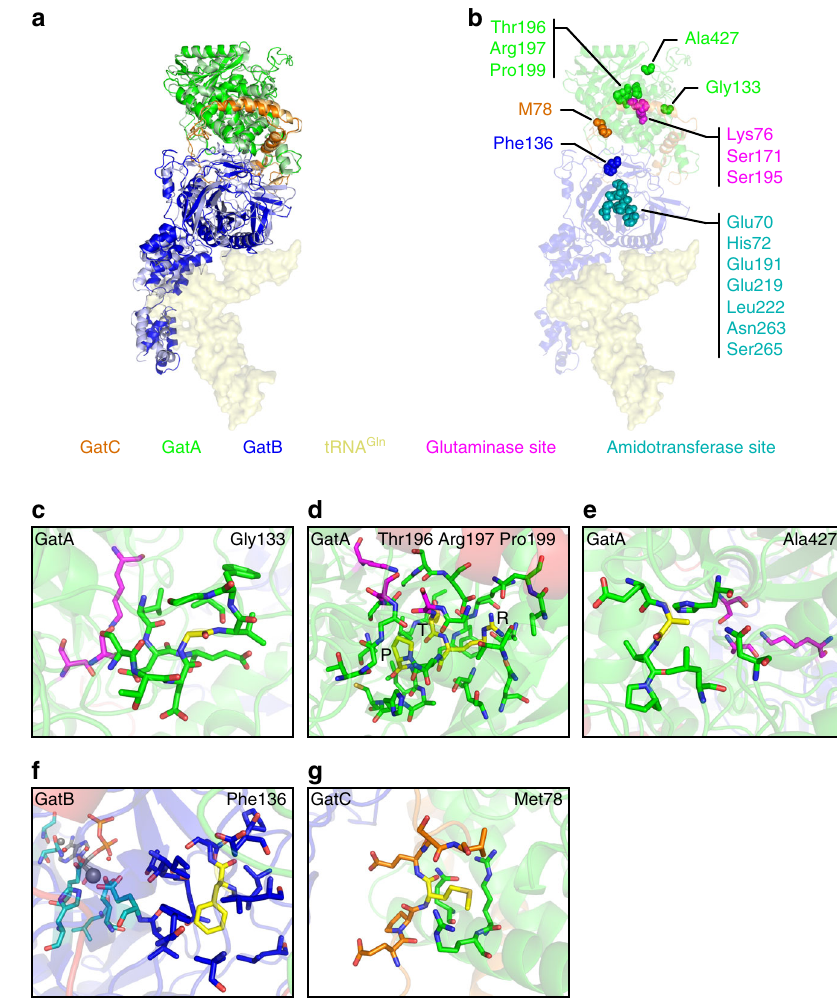
Fig. 2 Modeling of the Homo sapiens GatCAB complex and mapping of variants. a Representation of the bacterial GatCAB (light colors) with bound tRNA Gln (light yellow surface) and the superimposed modeled human complex (GatA in green, GatB in blue, and GatC in orange). b Mapping of residues involved in catalysis at glutaminase site in GatA (magenta) and at the amidotransferase site in GatB (teal), and residues found to be mutated in patients, to the structure of the human GatCAB model. c – g Inspection of the microenvironment of mutated residues (yellow) in the human GatCAB model. Color-coding for the individual subunits of the GatCAB complex as in a and b . In each case, the mutated amino acid is shown in yellow, GatA residues in green, GatB residues in blue, glutaminase side in magenta; nitrogen is shown in dark blue and oxygen in